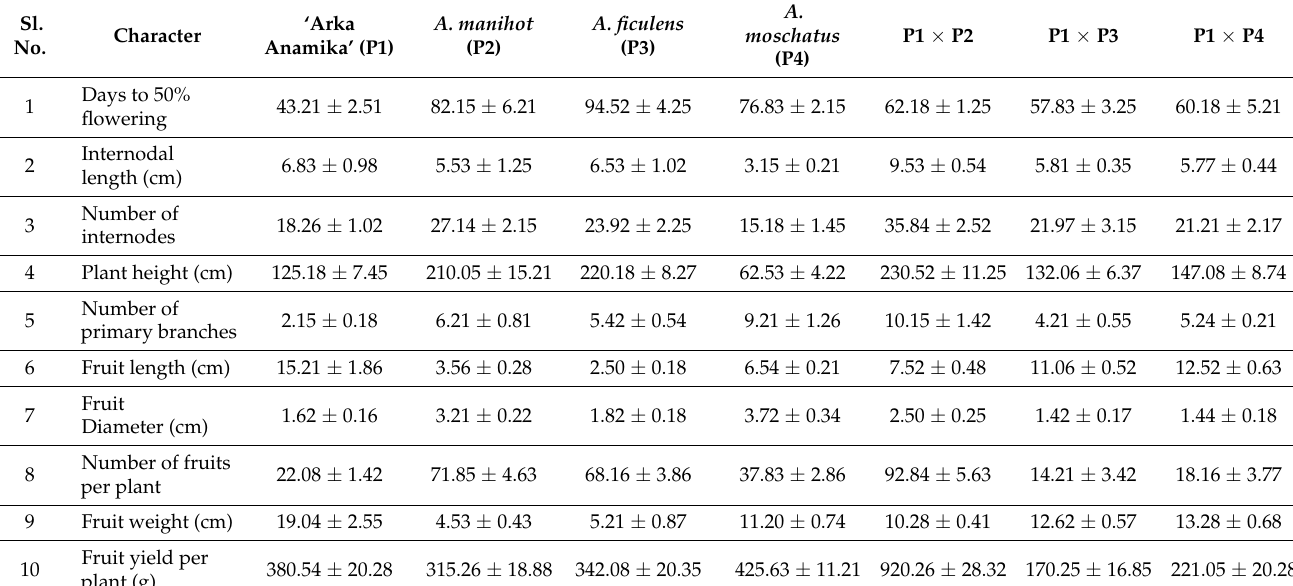
Table 5. Mean performance of quantitative traits of interspecific F 1 hybrids of Abelmoschus species with their